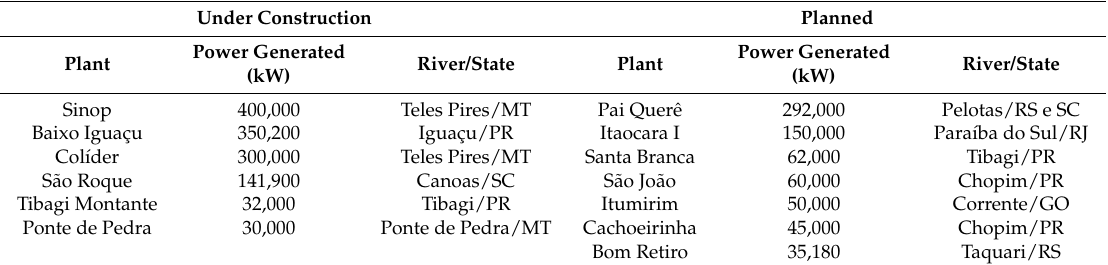
Table 2. Hydroelectric plants: Under construction and planned—data from